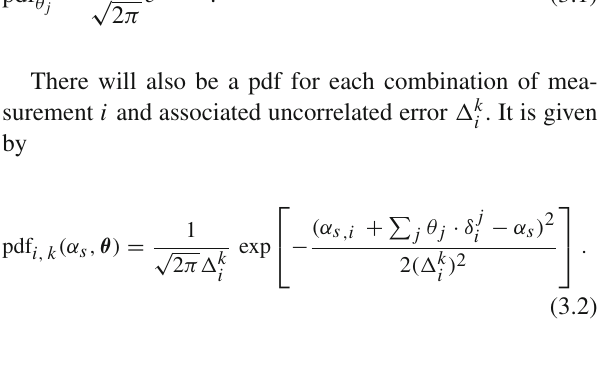
Table 8 Correlated, uncorrelated and total luminosity uncertainties with respect to the top-quark-pair production cross section (in percentages) [40–46]